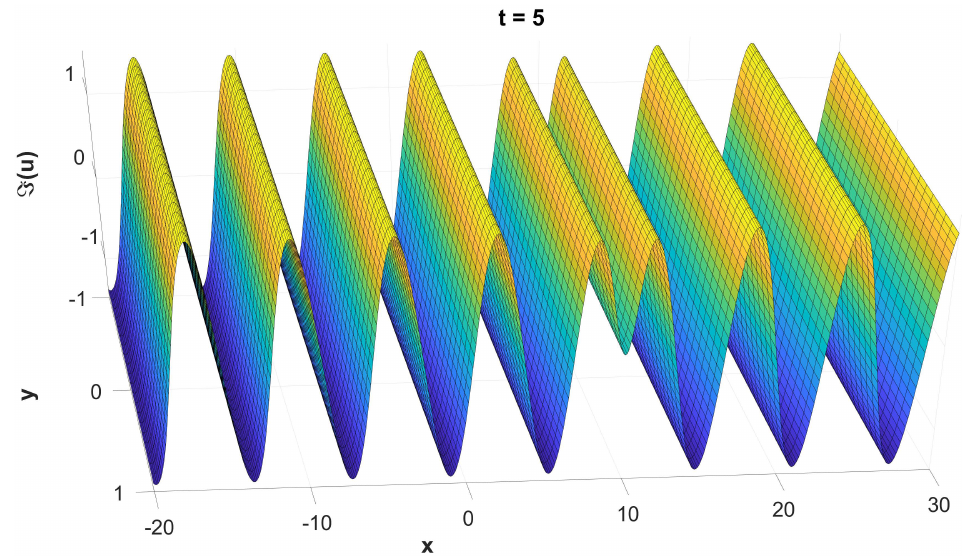
(cid:0) (cid:1) u ( x , y , t = 5 ) , evaluated numerically.